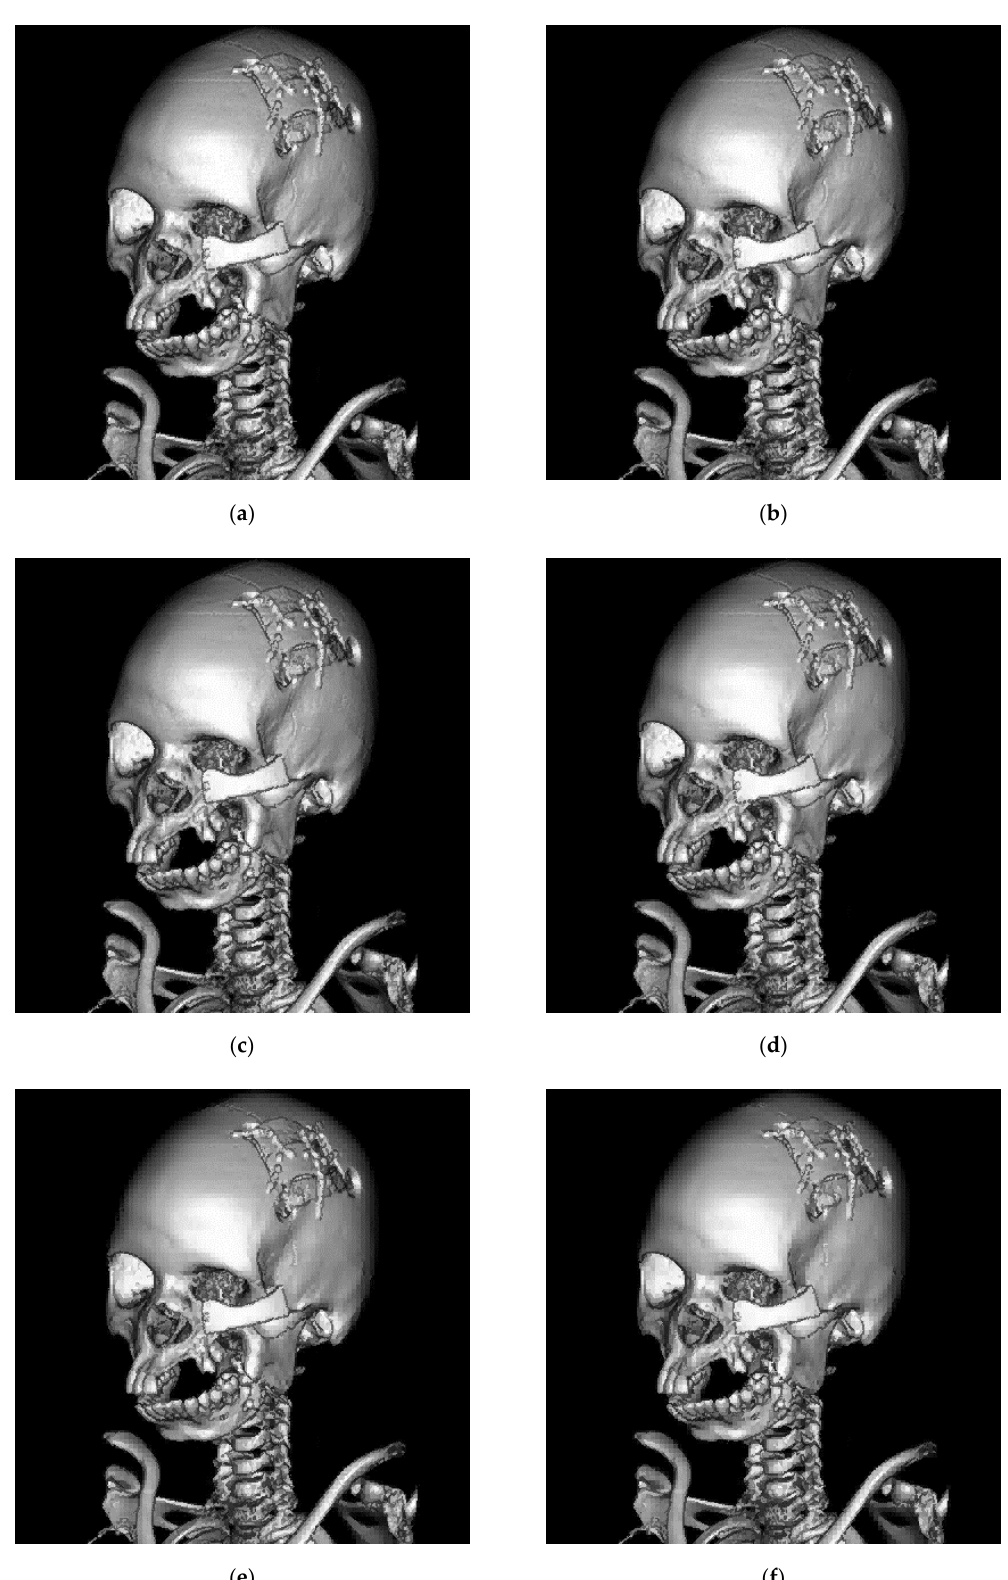
Figure 11. Results of the proposed method using the test image Phenix (with different threshold values). ( a ) Threshold = 2. ( b ) Threshold = 4. ( c ) Threshold = 8. ( d ) Threshold = 16. ( e ) Threshold = 24. ( f ) Threshold = 32. It can be seen in ( e ) and ( f ) that some artifacts occur in the hindbrain region.